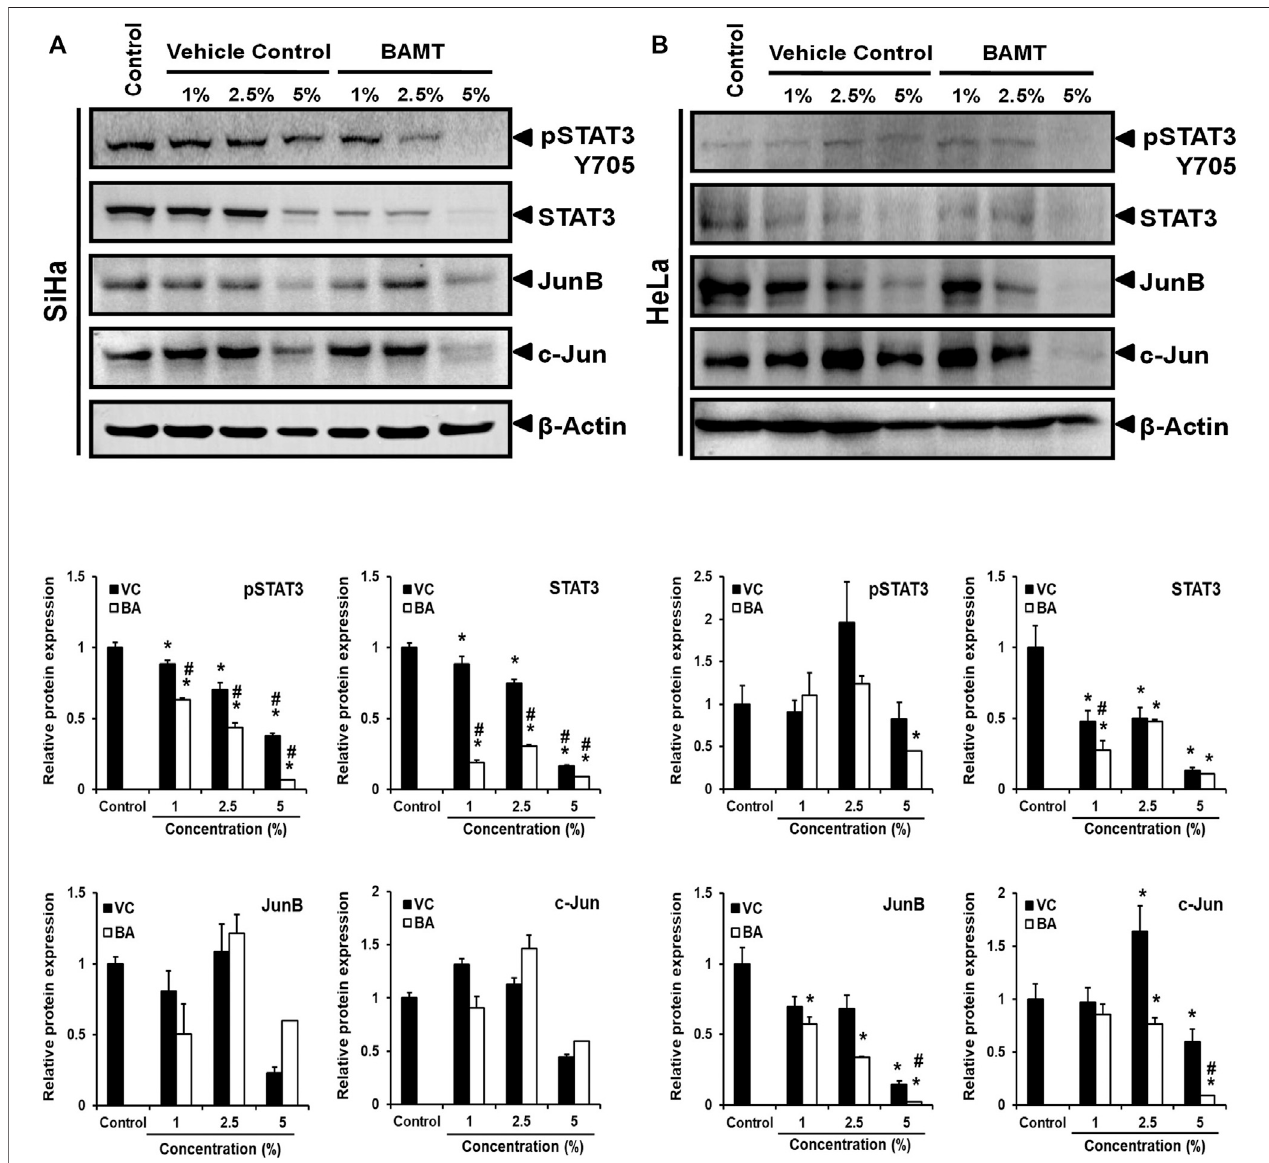
FIGURE 3 | Effect of BAMT on expression of pSTAT3, STAT3 and AP-1 components, JunB and c-Jun. (A) . Representative immunoblots of total cellular proteins (40 µg/lane) isolated from BAMT-treated SiHa (A) or HeLa cells (B) separated on 10% SDS-PAGE were transferred on PVDF membrane and fi rst probed for pSTAT3(Y705), and then reprobed for STAT3, JunB, c-Jun and β -actin (upper panels) . Graphs (Lower panels) show aggregated normalized fold change in band intensities of pSTAT3, STAT3, Jun B and c-Jun obtained from densitometric analysis. Values are means ± S.D. (indicated as error bars) of the three independent measurements. * p value < 0.05 vs. control. # p value < 0.05 vs. vehicle control